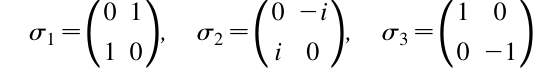
FIG. 4. The fractional part of the spin tune of AGS with four helices. Each of the three curves corresponds to a given strength for each set of the four helices. The region of the spin tune gap which corresponds to a strength of the helices of B ¼ 2 : 1 T is highlighted